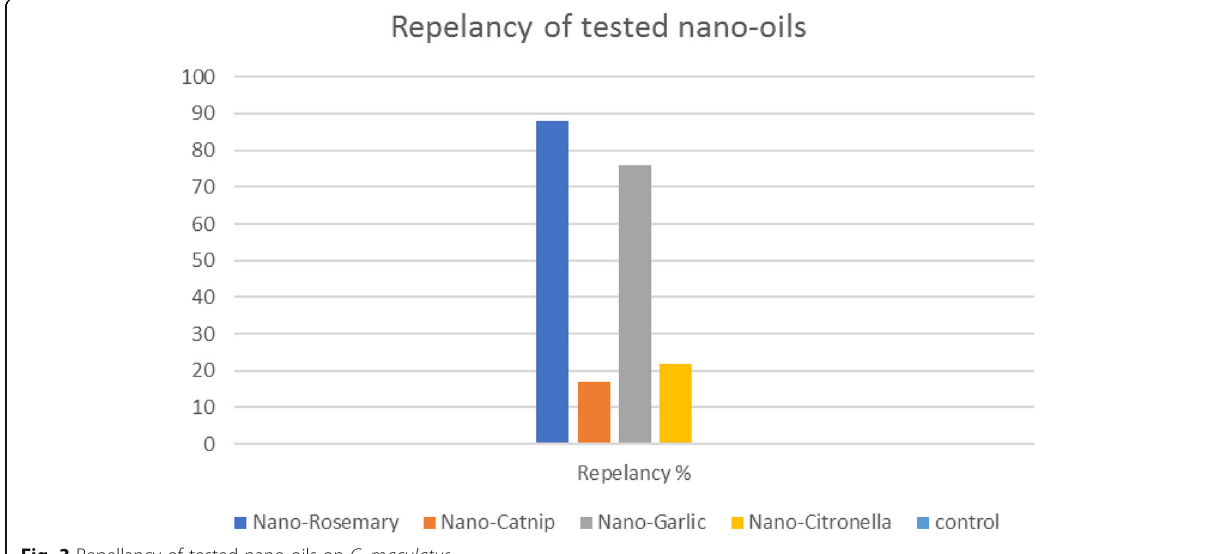
Fig. 3 Repellancy of tested nano-oils on C.